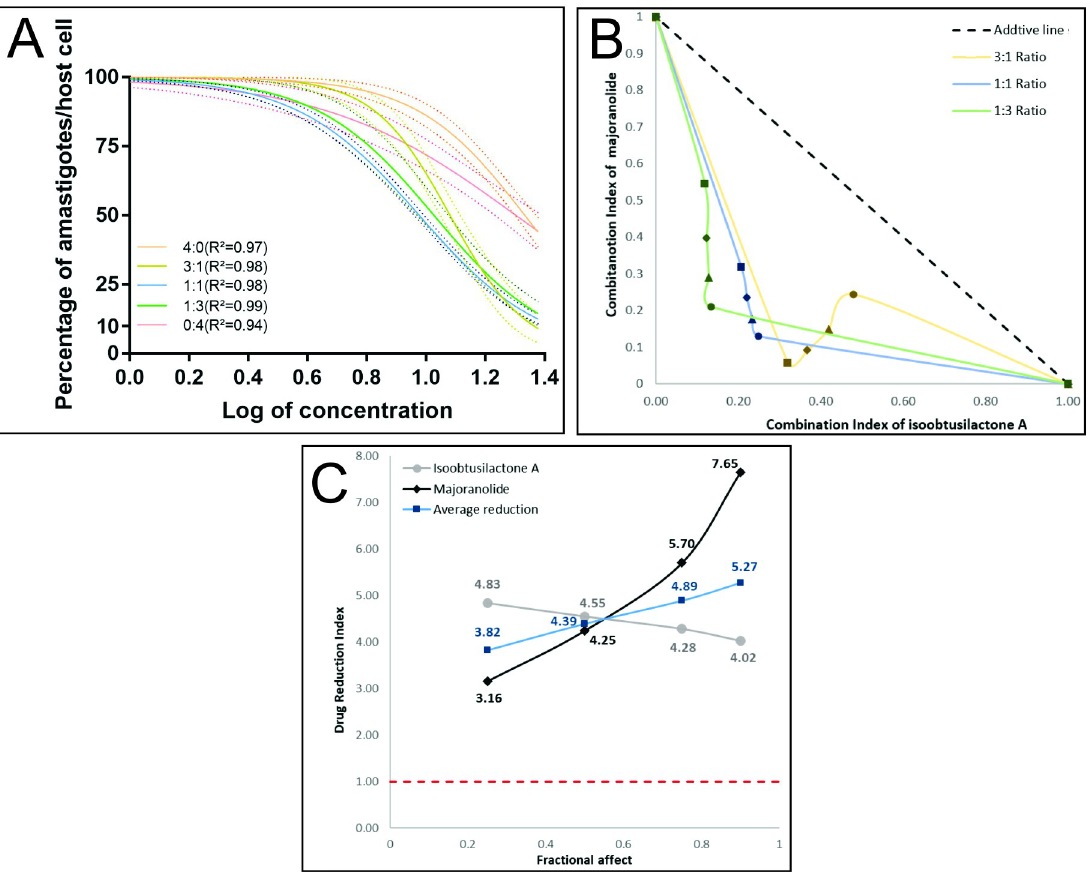
Fig 2. Synergism effect of isoobtusilactone A and majoranolide against amastigotes. A: Nonlinear regression with variable slope of each ratio (4:0-isoobtusilactone A alone; 0:4 majoranolide alone); B: Normalized isobologram of combination index of the ratios 3:1,